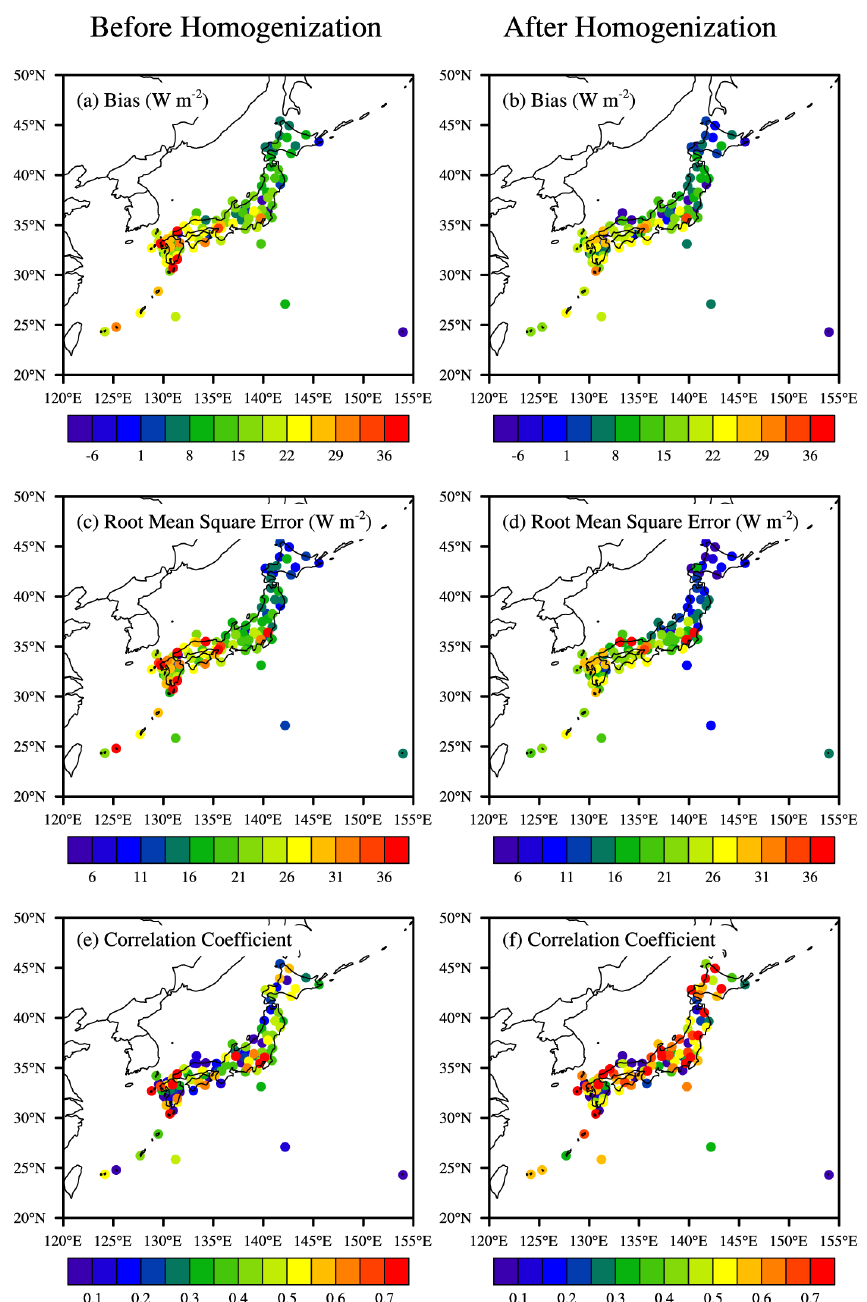
Figure 4. The spatial distribution of bias, root mean square error, and the correlation coefficient between SunDu-derived surface incident solar radiation ( R s ) and observed R s before (a, c, e) and after (b, d, f) homogenization. Improvements were made at most sites after